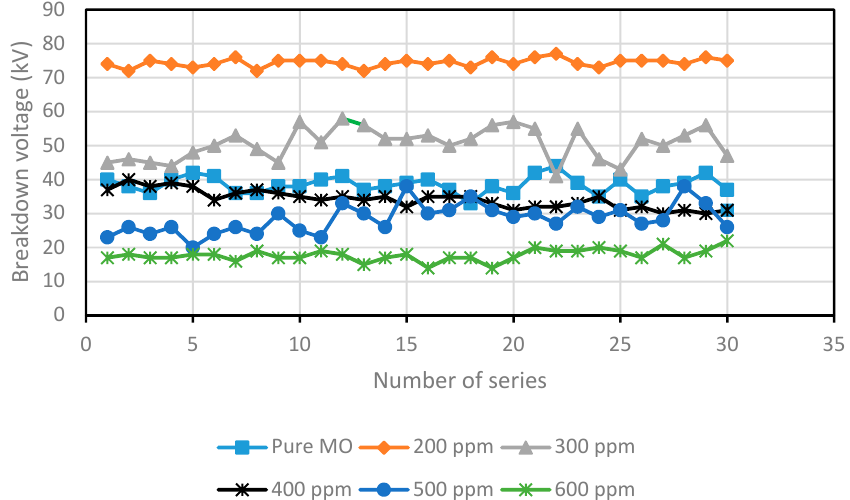
Figure 1. The breakdown voltage for various concentrations of the mineral oil (MO)/CCl 4 scavenger.